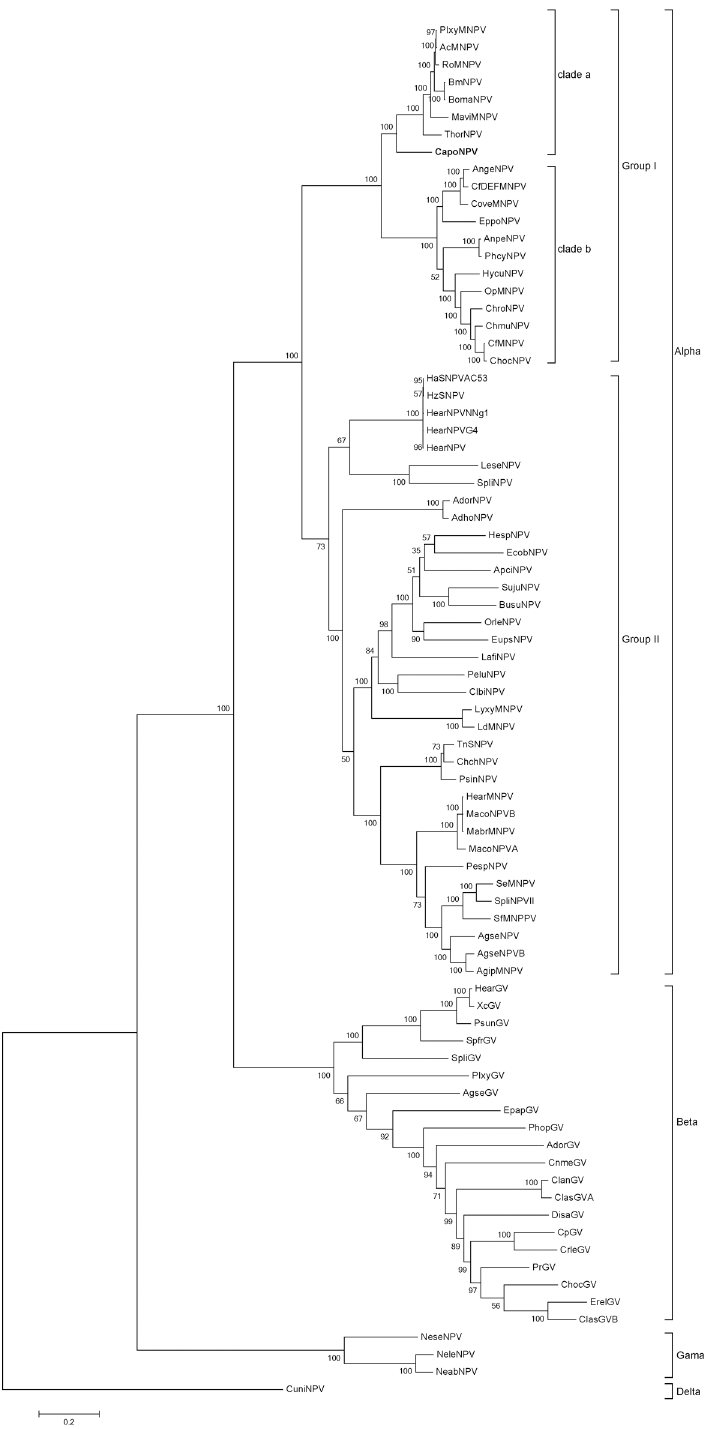
Fig 2. Phylogenetic tree. Phylogenetic analysis was performed using amino acid sequence alignments of the combined 37 core genes from 79 sequenced baculoviruses with Maximum Likelihood method. It is tested by Bootstrap method with a value of 1000. Numbers at nodes indicate bootstrap scores, only the value > 50% are shown. CapoNPV is highlighted in bold.